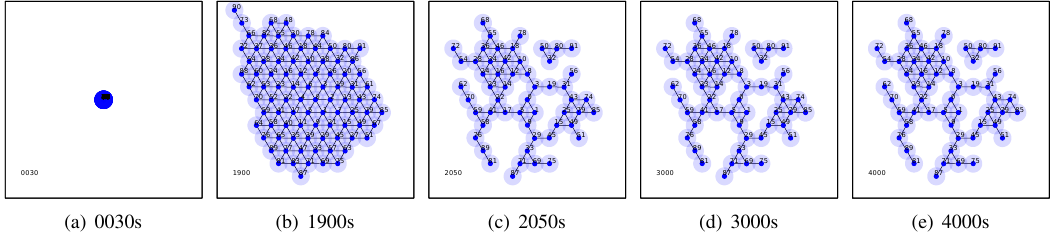
Fig. 10: BAR algorithm developed by Bartolini et al. (2010). Deployment snapshots with 30% of node disappearing at 2000s and the self-healing